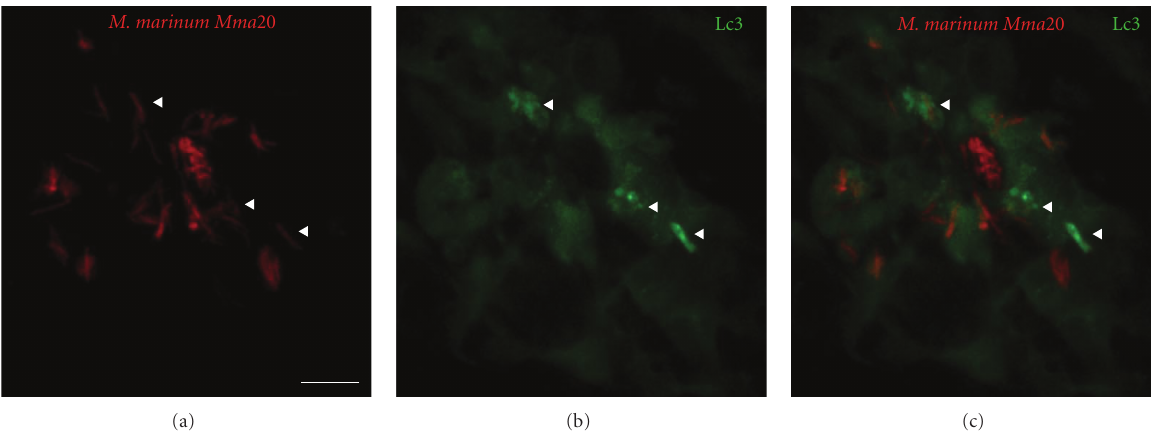
Figure 2: In situ detection of autophagy by Lc3 accumulation. CMV::LC3-GFP transgenic [15] zebrafish embryos (28hpf) were injected into the caudal vein with 200 colony-forming units (CFU) of M . marinum Mma20 expressing a pMST3::mCherry vector. Confocal images were taken of a tail region of the developing larva at 3 days after infection (3dpi), a point at which the M . marinum infection (a) has been established. Low levels of Lc3-GFP signal (b) can be observed throughout the cells, whilst brighter regions (indicated by arrowheads) are only observed upon Lc3 accumulation and formation of autophagic membranes associated with bacteria (c). Scale bar: 10 μ m.